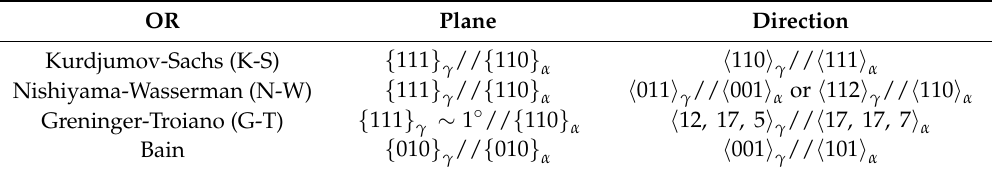
Table 1. Commonly used orientation relationship (OR) models used to describe the relation between austenite and martensite in steels, from